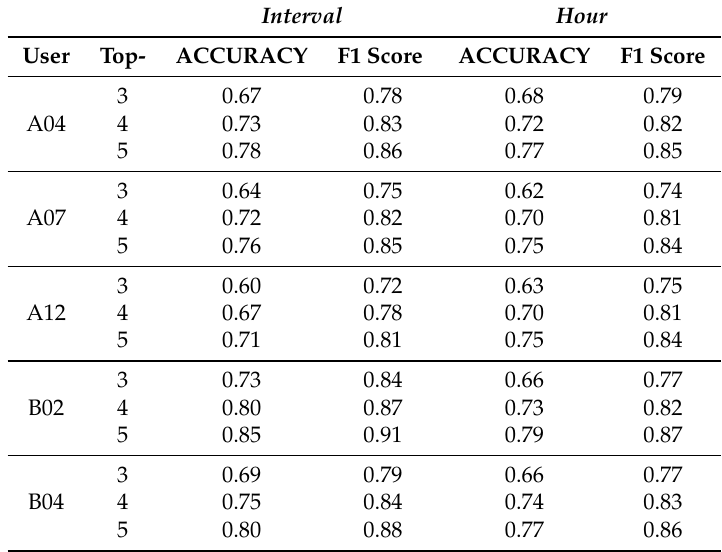
Figure 8. The figure shows the statistical distribution of application usage with user B02. Table 1. Performance details of the proposed method with top-3 prediction